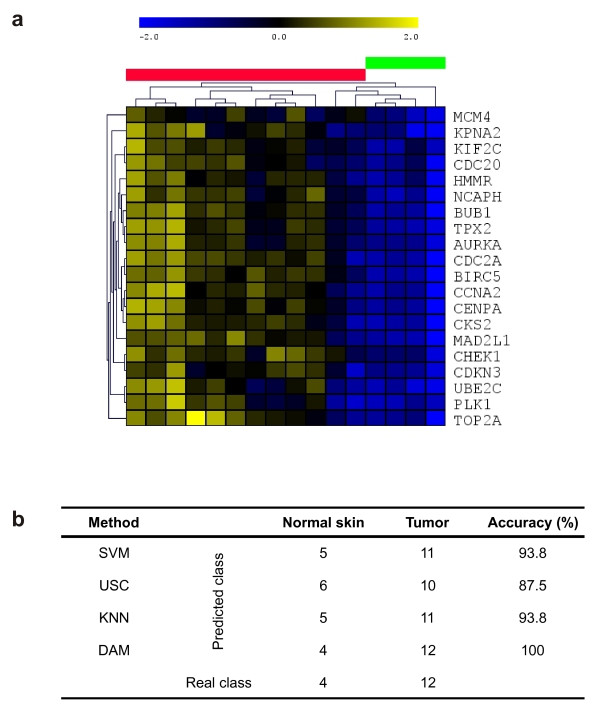
Validation of 20-gene signature in the mouse testing dataset. (a) Hierachical clustering (pearson distance, average linkage) of the 20-gene signature expression pattern in the testing dataset. Sample colors: green, normal control skin; red, mouse tumors. (b) Prediction analysis results. Shown is the real number of samples belonging to either normal skin class or tumor class, the classification result for each class using 4 different prediction methods, and the accuracy of the methods.